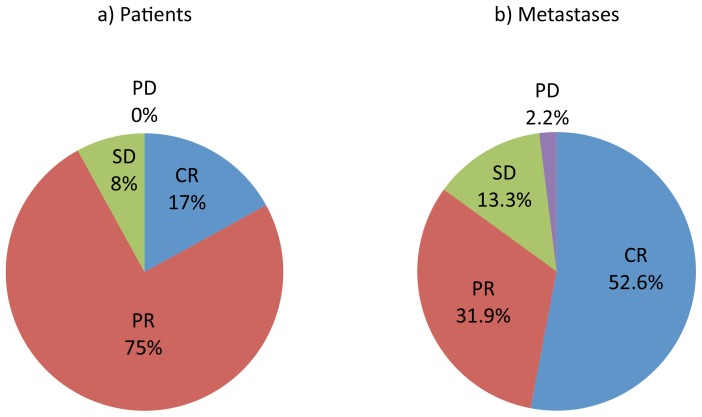
The proportions of categories of response a) by patients (N = 24), b) by metastases (N = 135).Abbreviations: CR, complete response; PR, partial response; SD, stable disease; PD, progressive disease.